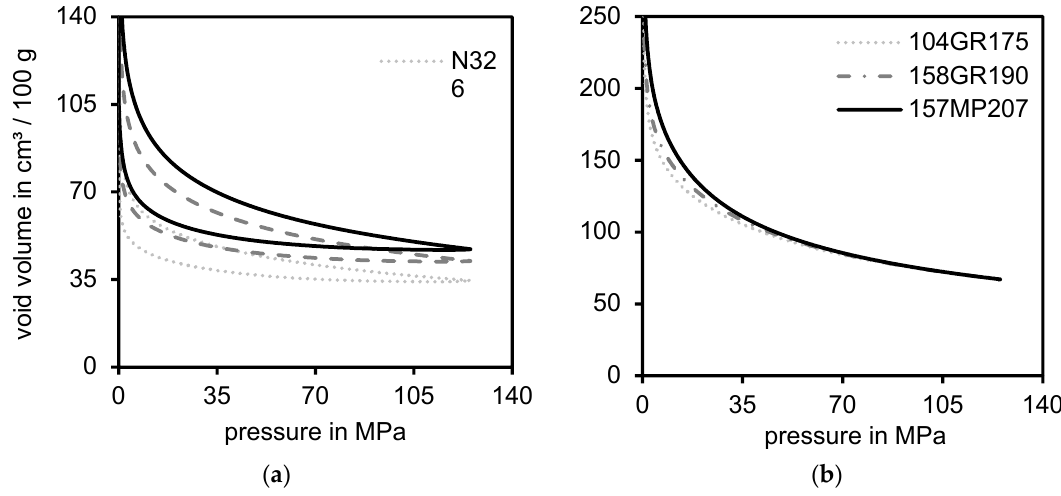
Figure 6. Comparison of three different types of carbon black ( a ) and three different types of silica ( b ) measured by means of the void volume structure tester.